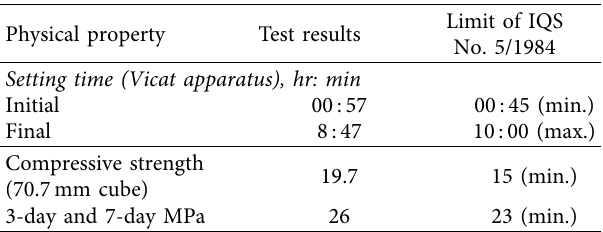
Figure 1: Concrete casting. Table 1: Chemical properties of cement [16]. Table 2: Physical properties of cement [16].